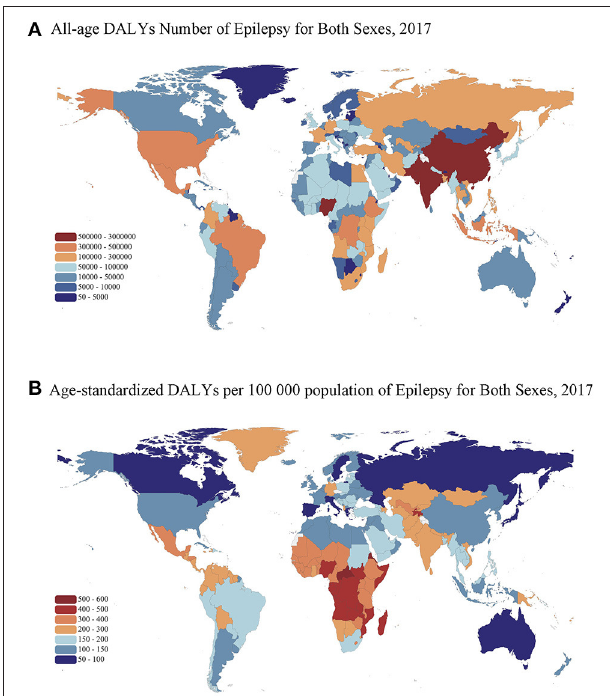
FIGURE 3 | Maps of all-age DALY number and age-standardized DALYs rate of epilepsy in 2017 for both sexes. (A) All-age DALY number. (B) Age-standardized DALY rate per 100,000 population. DALYs, disability-adjusted life-years. The boundaries shown and the designations used on the maps do not imply the expression of any opinion of the authors.